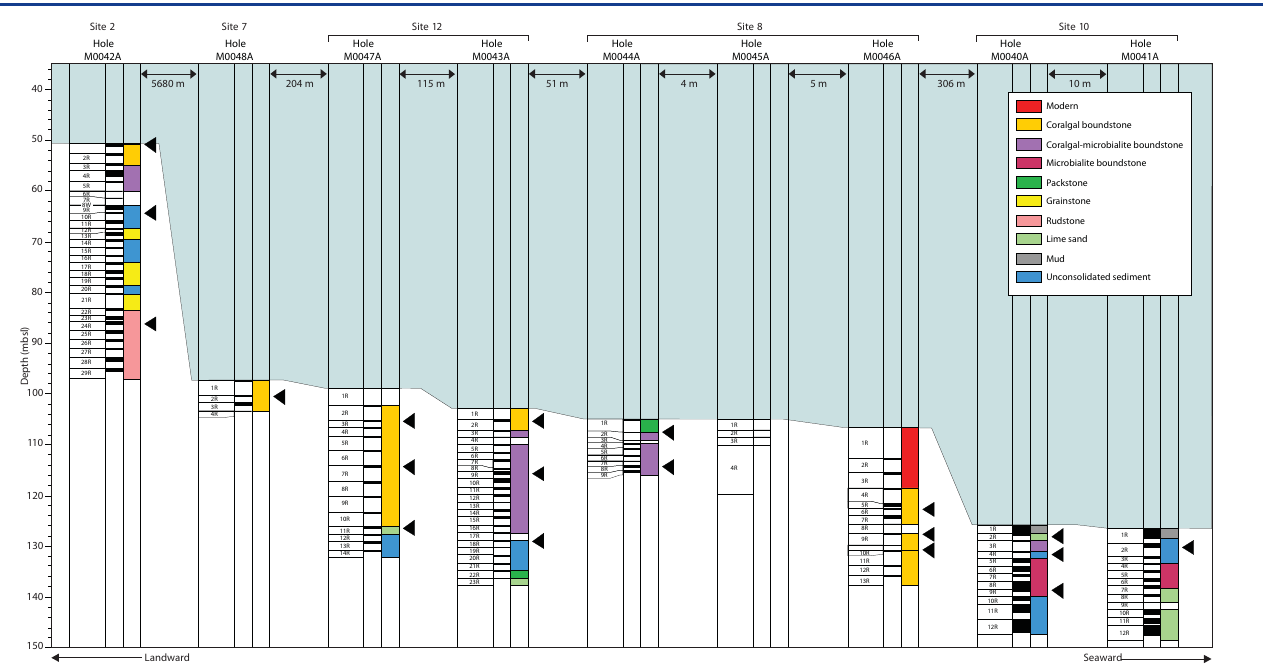
Figure 5. Lithostratigraphic summary of holes on the Transect HYD-01 (Sites from landward to seaward; M0042A, M0048A, M0047A, M0043A, M0044A, M0045A, M0046A, M0040A, and M0041A).